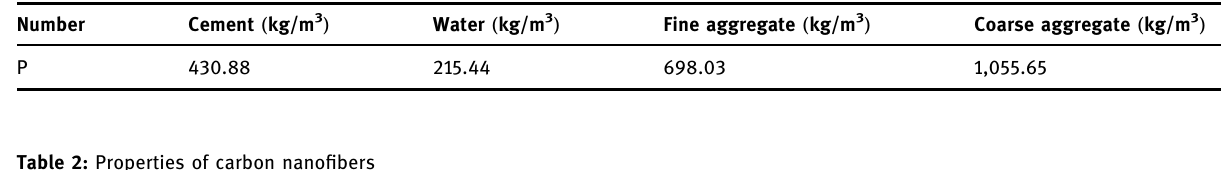
Table 2: Properties of carbon nano fi bers Content ( % ) Diameter ( nm ) Length